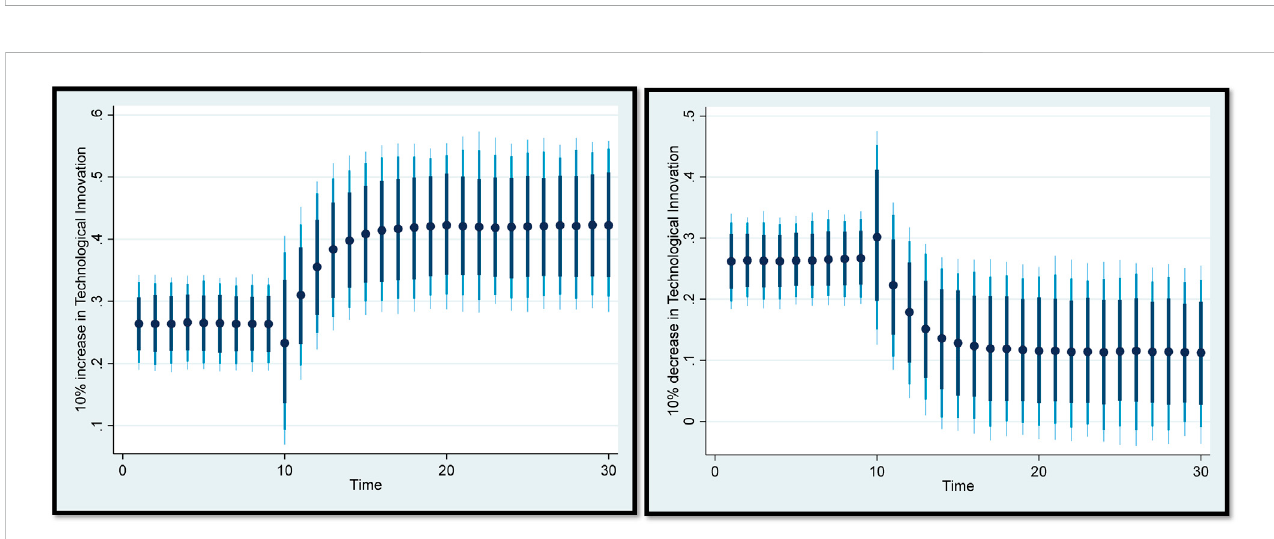
FIGURE 8 Impulse response plot for technological innovation and CO 2 emissions. An increase and a decrease of 10% in technological innovation and its effect on CO 2 emissions, where dots denote the average prediction value. The dark blue to light blue lines show 75%, 90%, and 95% con fi dence intervals,